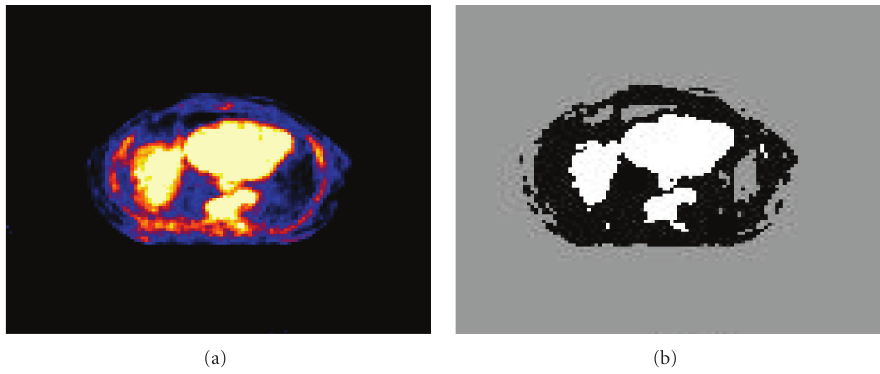
Figure 7: Clinical PET data: (a) original PET image and (b) classified image.